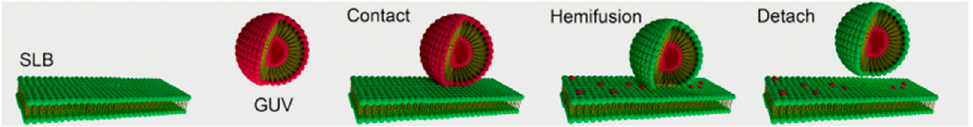
Figure 8. “Hemifusion yields asymmetric GUVs (aGUVs)” [20] [Reuse permitted by